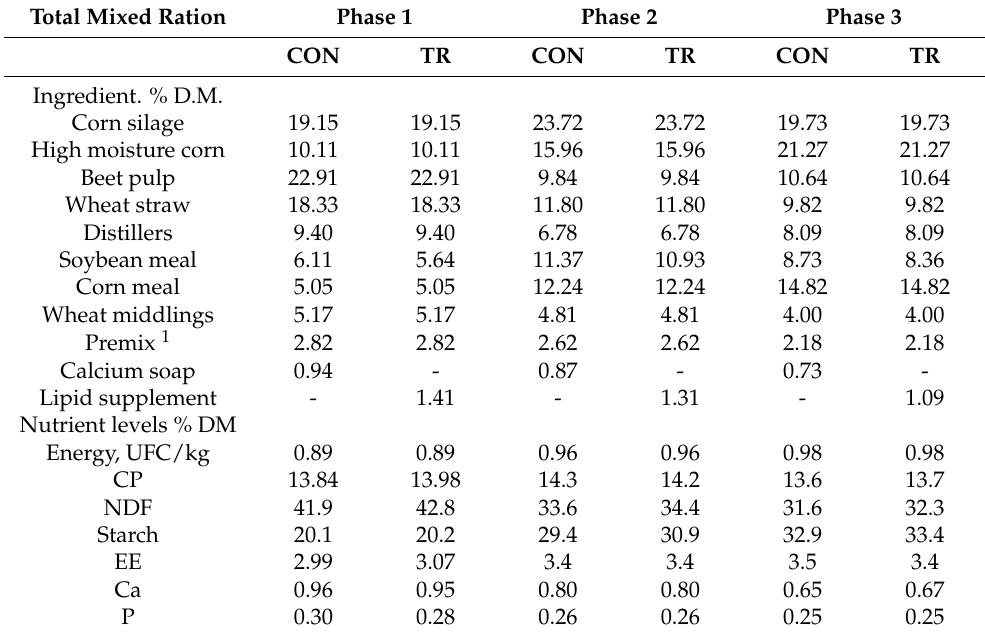
Table 1. Ingredients and nutritional composition of control diet (CON) and diet supplemented with omega-3 lipid supplement (TR) during different fattening phases. Total Mixed Ration Phase 1 Phase 2 Phase 3 CON TR CON TR CON TR Ingredient. % D.M.